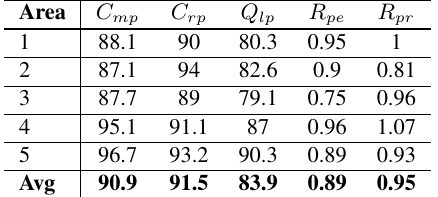
Table 2: Pixel-based and geometric evaluation of building detec- tion results. Pixel-based: C mp = completeness, C rp = correct- ness and Q = quality in percentage. Geometric: planimetric lp accuracy with respect to R pe = extracted and R pr = reference buildings in metre.